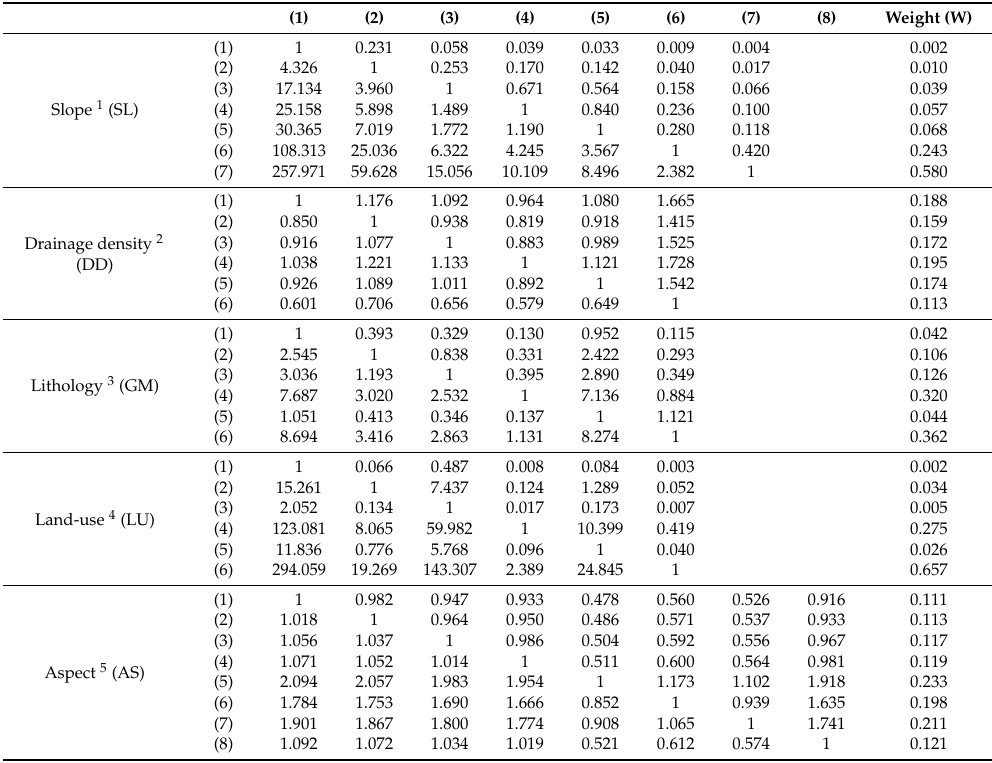
Table 4. Calculating the weight of factors by